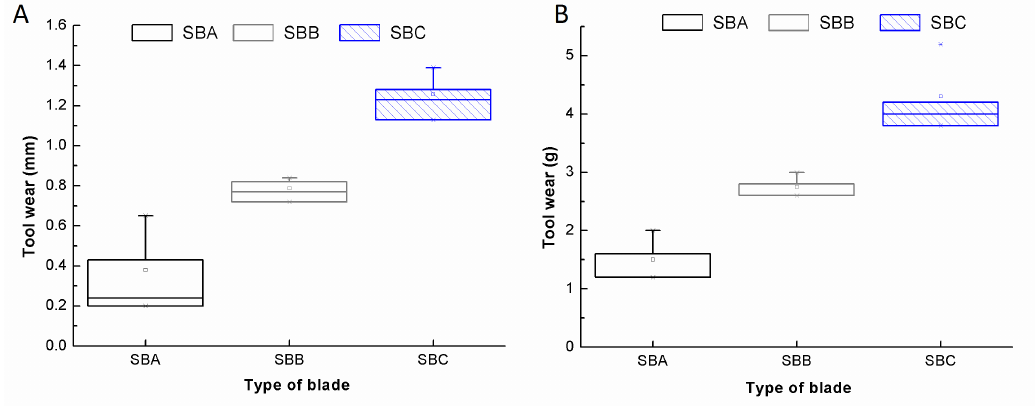
Figure 4. Boxplots of the tool wear in the three studied diamond blades when reaching the stop criteria in terms of: diameter variation ( A ); and weight loss ( B